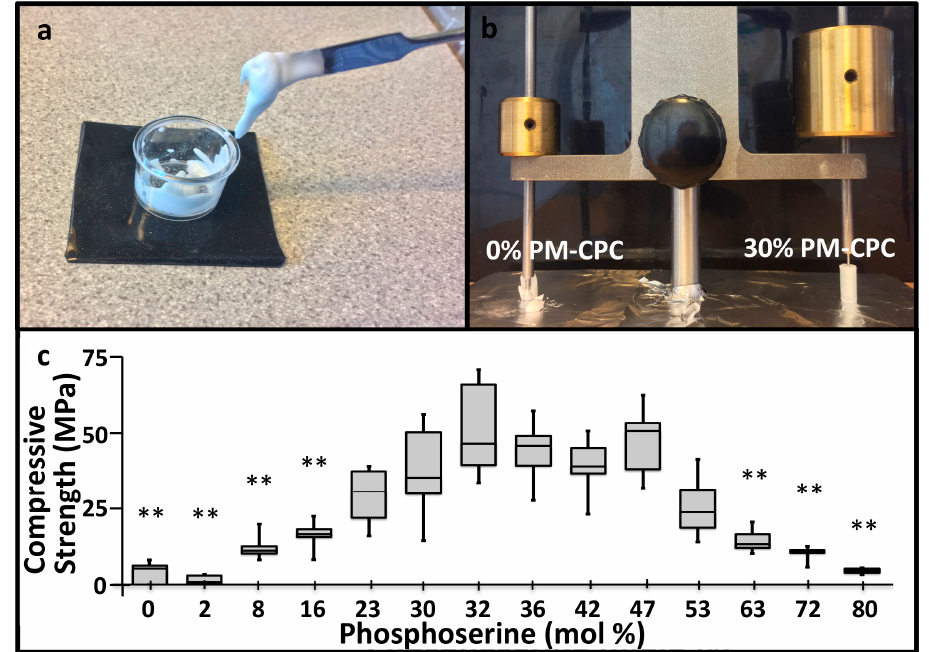
Figure 1. Physical appearance, setting, and compressive strength of phosphoserine-modified calcium phosphate cements (PM-CPCs). ( a ) PM-CPCs are liquids, which are easy to handle and mix, unlike α TCP cements, which are granular, chalky, and challenging to deliver. ( b ) The rapid cohesive strength of PM-CPC is visually represented (0% PM-CPC vs. 30% PM-CPC, 0.25 liquid-to-powder ratio (L/P)) by placing the Gilmore needle after curing/setting for 10 min. ( c ) The compressive strength of PM-CPCs with varied phosphoserine concentration (0.25 L/P, box plots represent the minimum, maximum, and median values, with whiskers denoting the first and third quartiles (25%, 75%)).Statistical analysis compared each group to the 30% PM-CPC using ANOVA with Games-Howell post hoc analysis, with * indicating p -values below 0.05, and ** indicating p -value below 0.01.